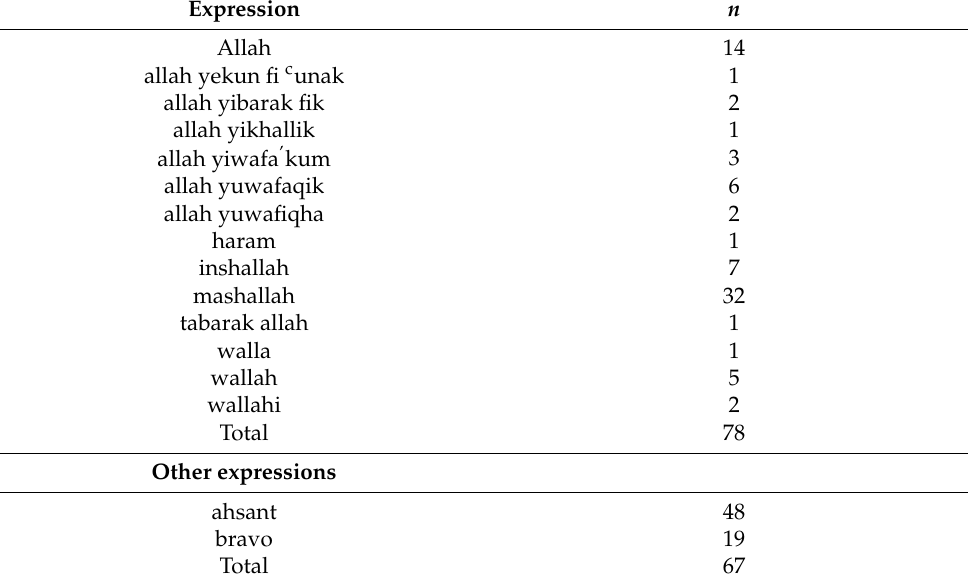
Table 3. Member of jury